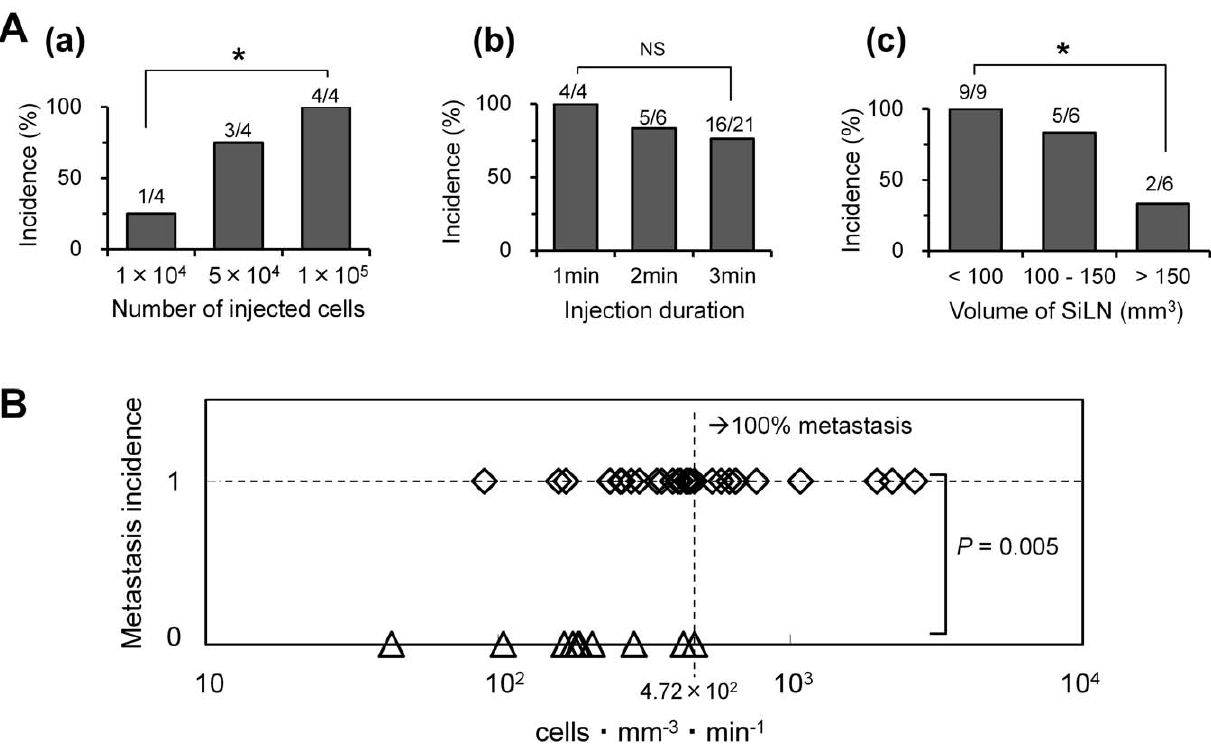
Figure 3. Parameters related to the incidence of metastasis. A. Effects of inoculation conditions on the incidence of lymph node metastasis. Metastatic incidence increased with injection of a larger number cells (a), did not vary significantly with injection duration (b), but decreased with a larger SiLN volume (c). In the values presented above the bars, the denominator represents the number of inoculated mice while the numerator represents the number of mice with metastases in the proper-ALN. NS indicates P . 0.05; *P , 0.05 calculated by Fisher’s exact probability test. B. Assessment of the correlation between the above 3 parameters and metastasis incidence, using a new parameter, cells mm 2 3 min 2 1 . When metastasis incidence was set at 1, 100% metastasis was achieved when the cells mm 2 3 min 2 1 value exceeded 4.72 6 10 2 (n=39). Analyses were performed with the Mann-Whitney U test.